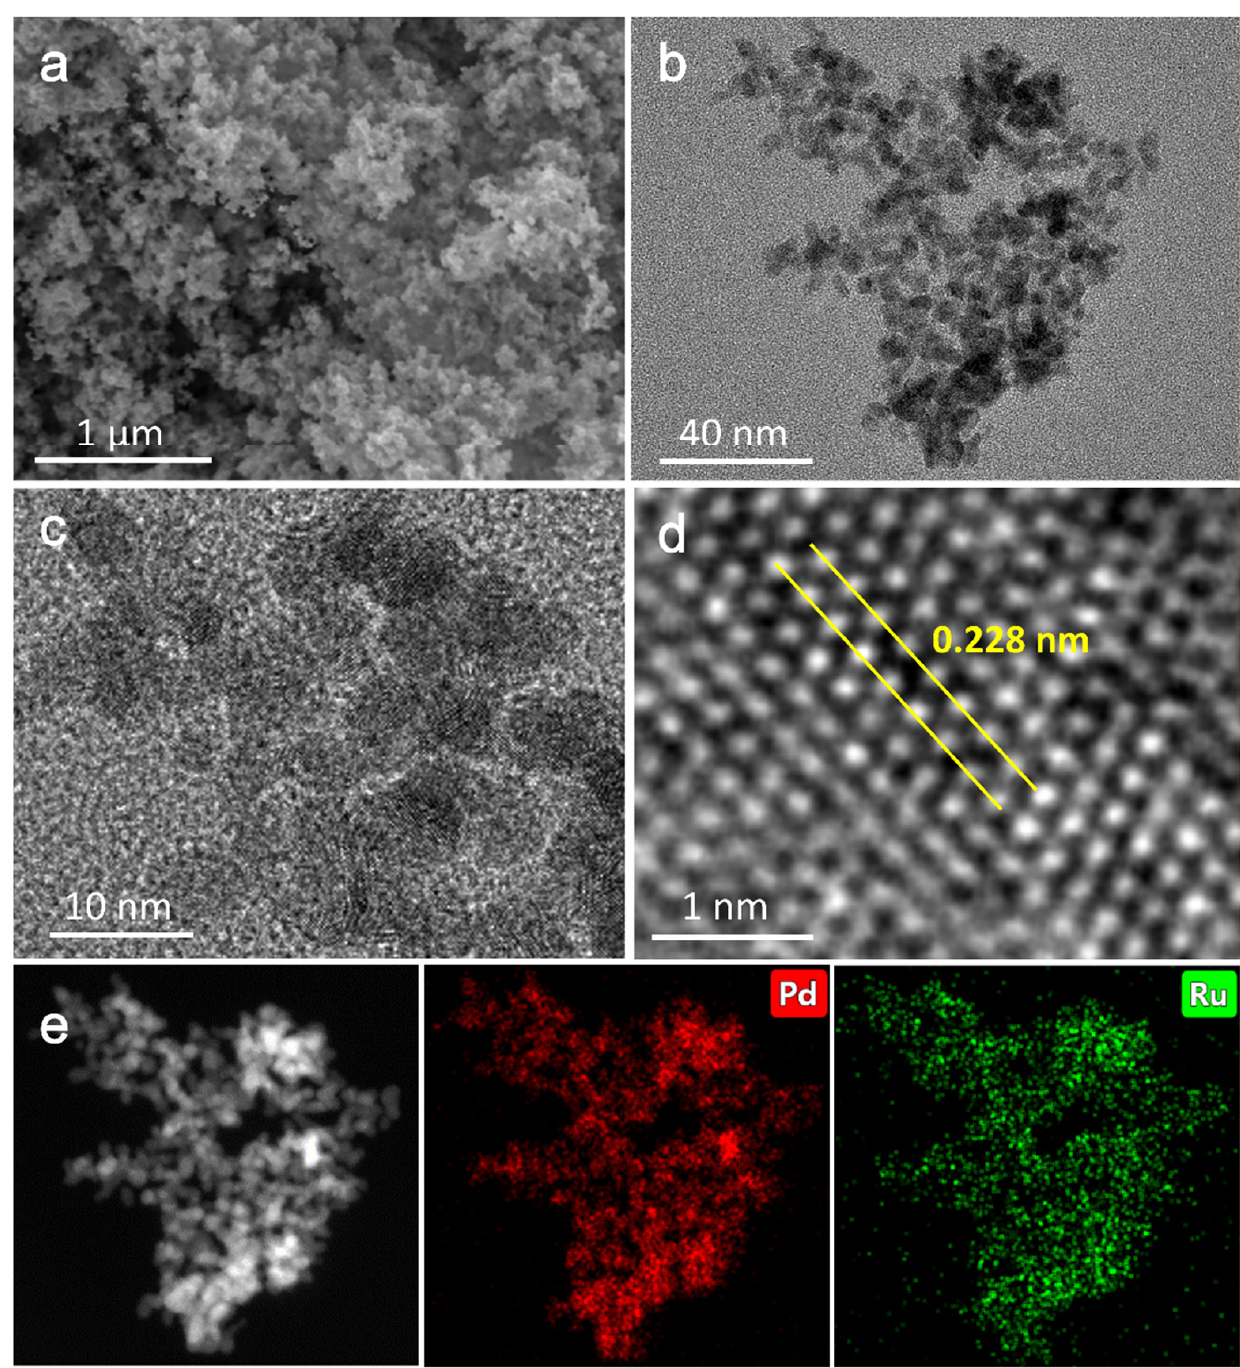
Figure 3. ( a ) Scanning electron microscope (SEM) image; ( b – d ) high-resolution transmission electron microscope (HRTEM) images of RuPd 3 ANs; ( e ) EDS mapping spectrum of RuPd 3 ANs.